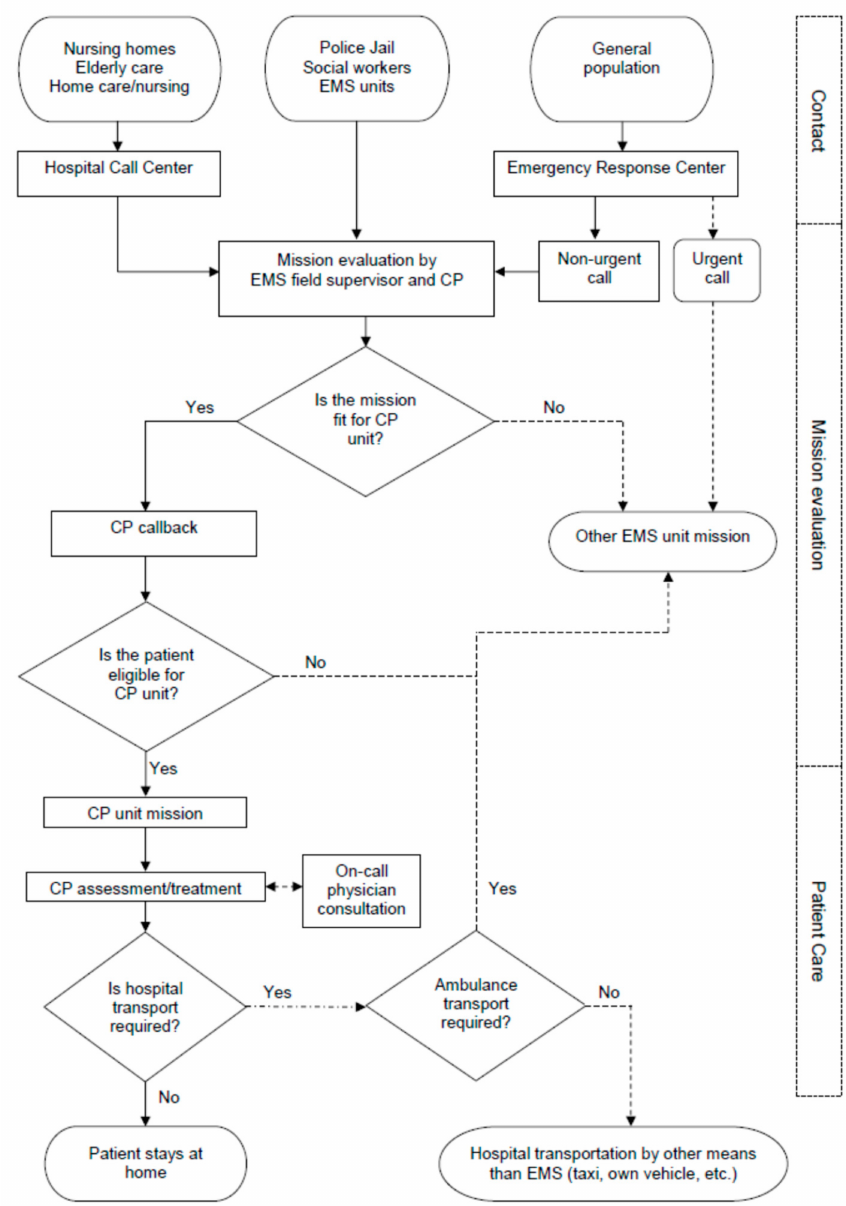
Figure 1. Community paramedic unit mission progression. EMS: emergency medical services; CP: community